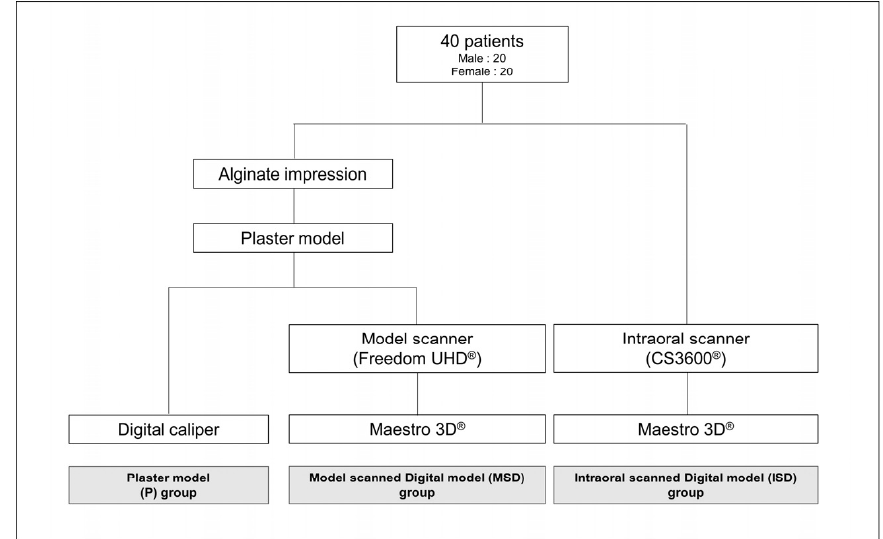
Figure 1. Illustration of the flow chart of model production according to model type.